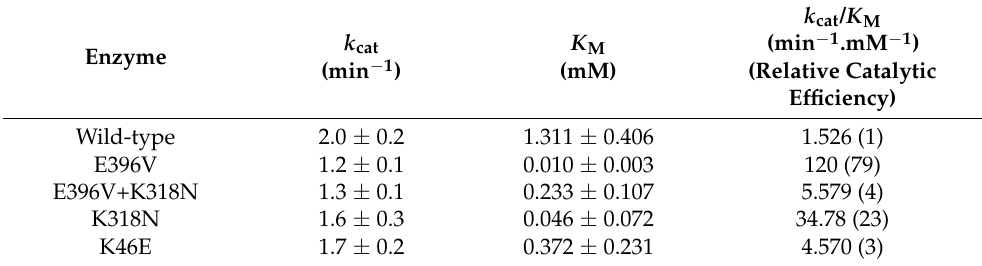
Table 1. Kinetic parameter of Lxmdh wild-type and its mutants with methanol as a substrate. k cat K M Enzyme (min −1 )